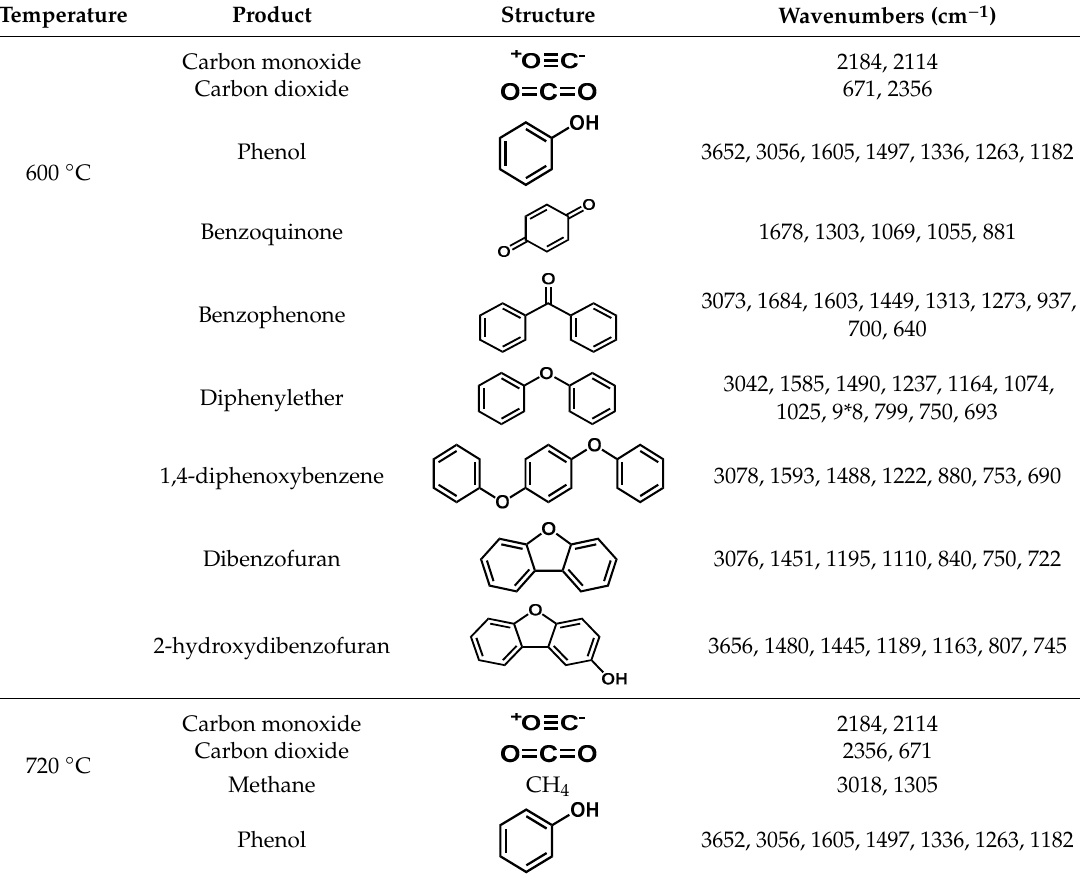
Table 2. Decomposition gases identified with TGA–FTIR at two decomposition steps of PEEK (600 °C and 720 °C), under nitrogen and a heating rate of 20 K/min.